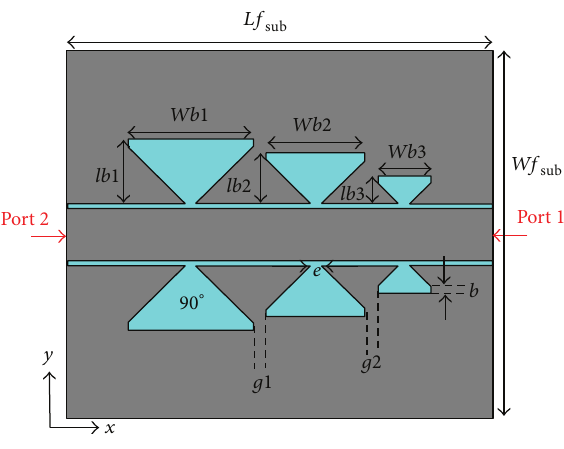
Figure 2: Geometry of the DGS filter.